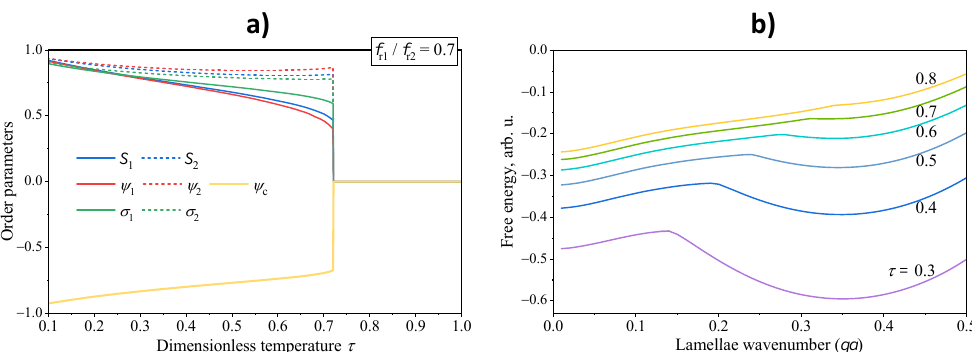
Figure 3. Transition from lamellar to disordered phase of the asymmetric rod-coil-rod triblock copoly- mer with f r 1 / f r 2 = 0.7 with growing dimensionless temperature τ . ( a ) Temperature dependencies of all order parameters. ( b ) Dependencies of free energy density on the lamellae wavenumber at different temperature values indicated on the lines. All other model parameters are the same as in Figure